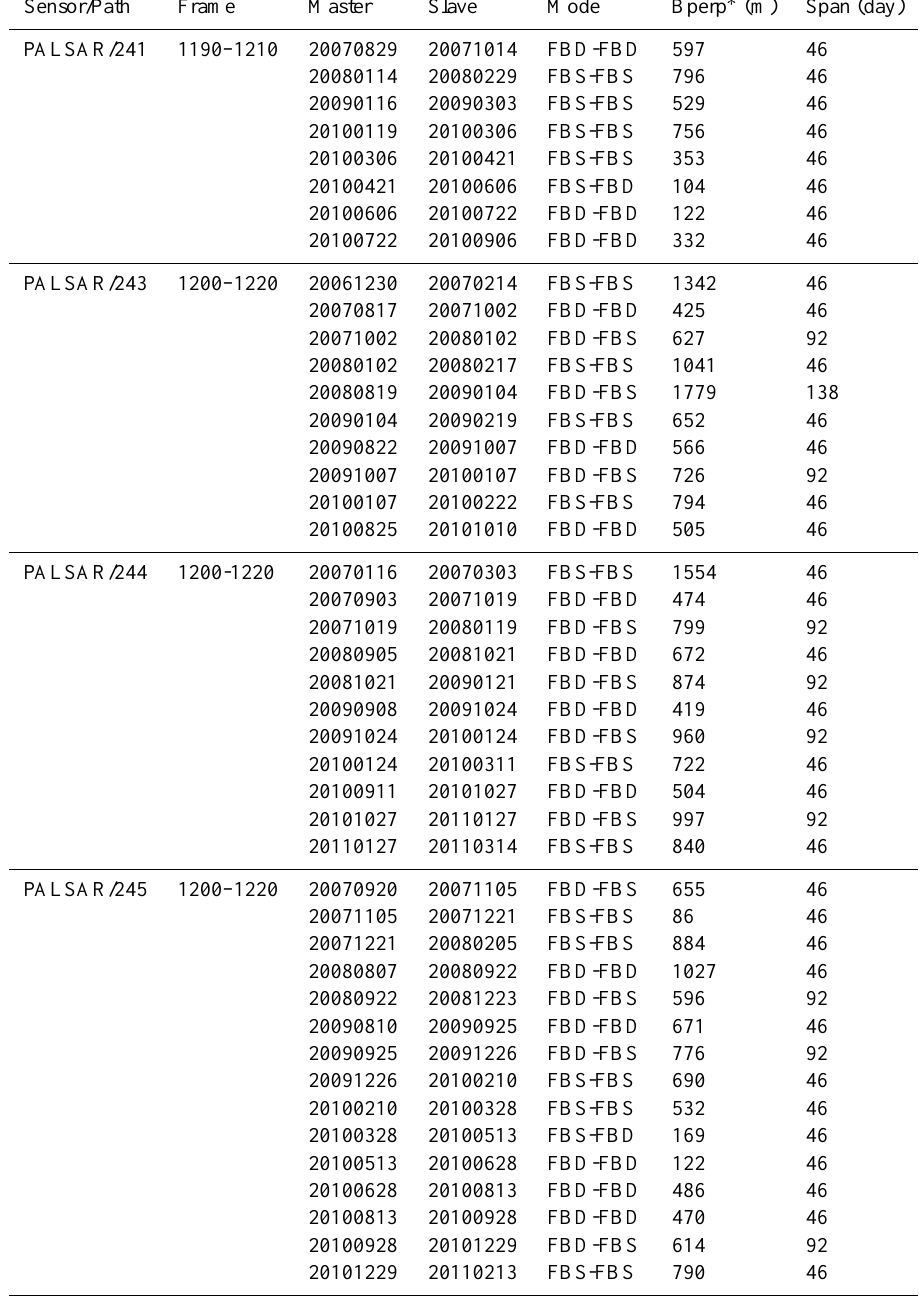
Table 1. Data list of the ALOS/PALSAR.